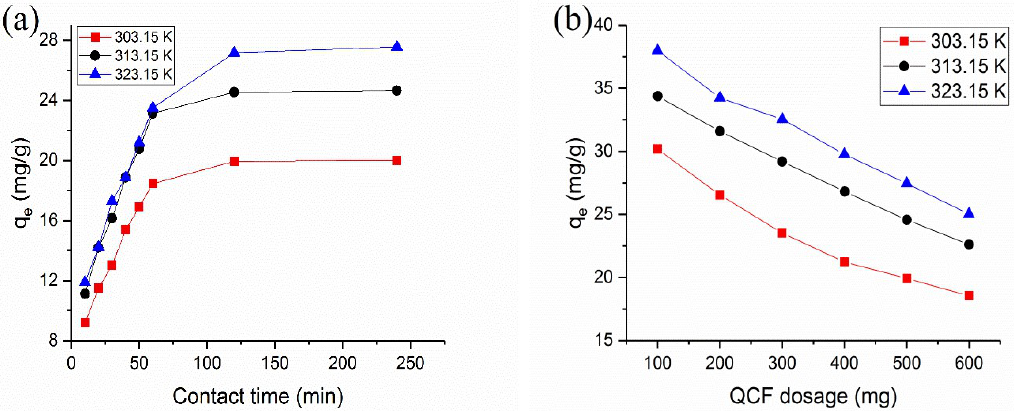
Figure 3. Effects of ( a ) contact time and ( b ) QCF dosage on the BTB adsorption onto QCF.